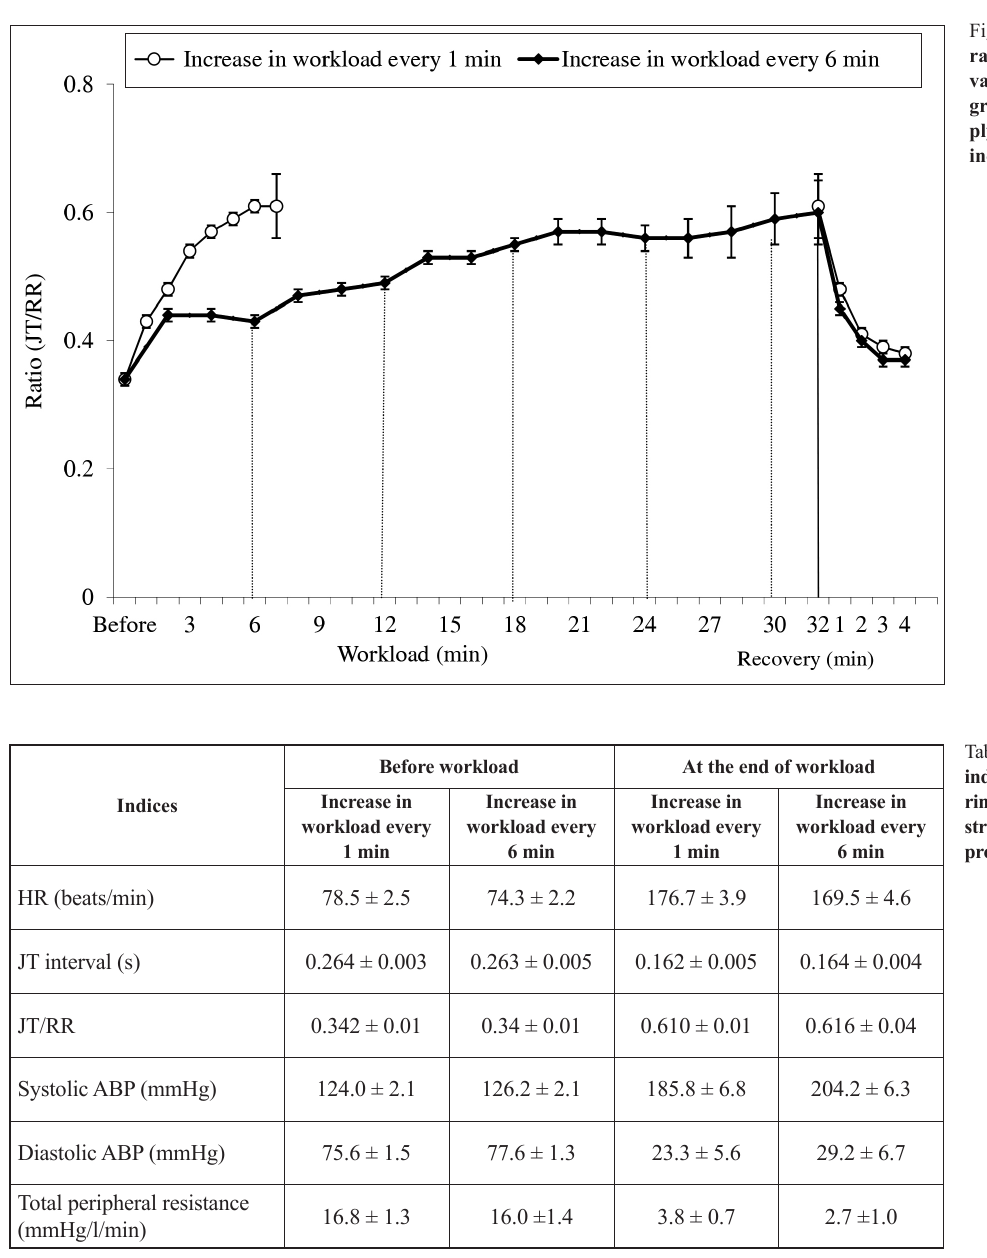
Figure 3. Dynamics of